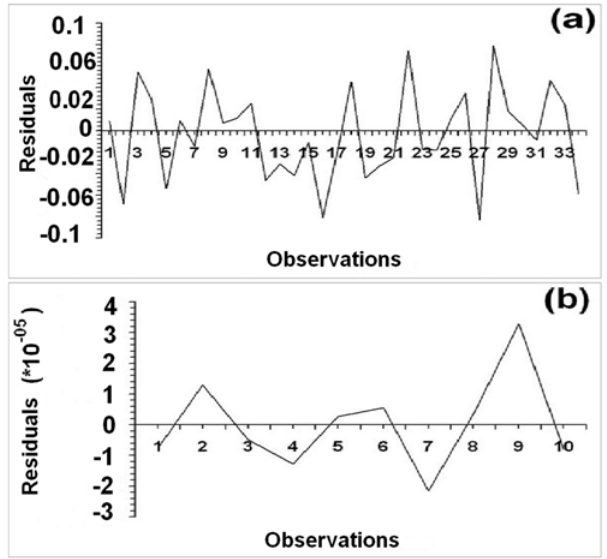
Figure 4. Residual plots for the fitted model. (a) for SPR values and (b) for total P.vivax deaths.